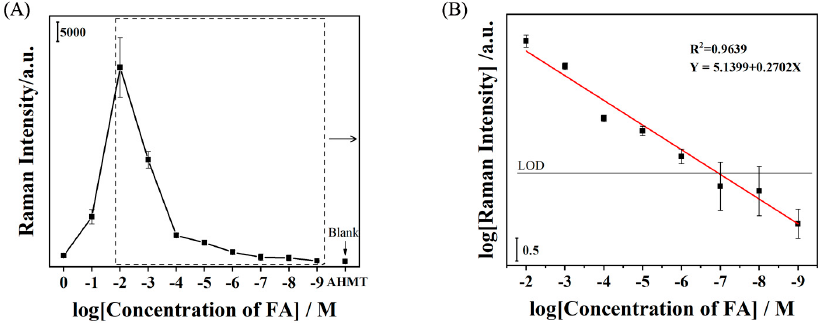
Figure 5. Concentration-dependent curve for the SERS detection of FA using AHMT as a probe (3.34 × 10 − 3 M). ( A ) Intensity of the Raman band at 1286 cm − 1 plotted vs the concentration of FA (from 1.44 to 1.44 × 10 − 9 M). ( B ) Linear relationship between the logarithmic Raman intensity and logarithmic concentration of FA (from 1.44 × 10 − 2 to 1.44 × 10 − 9 M).